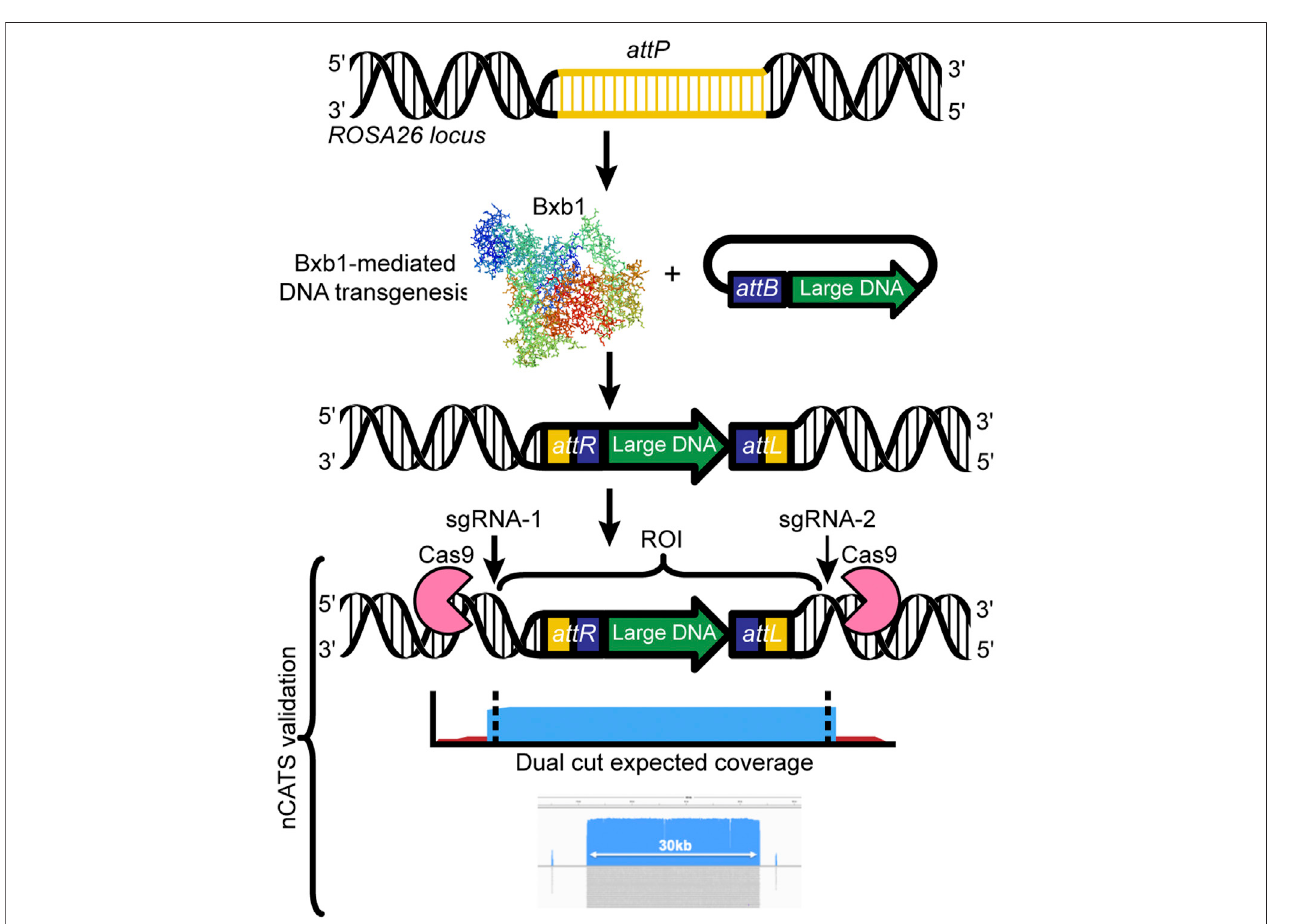
FIGURE3| DesigningaCas9targetedassay:Dualcutdesignsusea5 ′ and3 ′ sgRNA fl ankingtheregionofinterest.Theresultinglibraryleadstogenerationofhigh coverage over the desired region (e.g., 5 – 30 kb), ideal for transgene validation. We have successfully used mouse ear notches to generate suf fi cient high molecular weight genomic DNA to sequence a 30-kb region up to